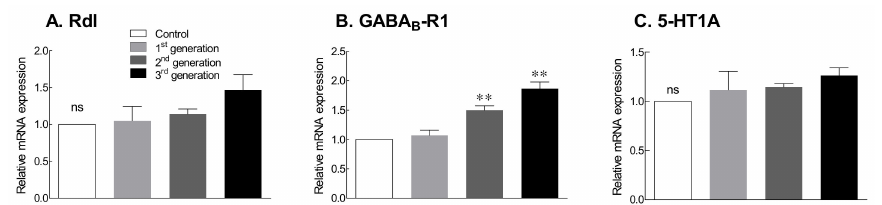
Figure 4. Effects of the GABA/5-HTP mixture (1.0% and 0.1%, respectively) on Rdl ( A ), GABA B -R1 ( B ), and 5-HT1A ( C ) mRNA expression in Drosophila flies by generation. Data are presented as means ± standard error of the mean for each group. Mean values with different letters over the bars indicate significant difference (** p < 0.01) according to Student’s t -test. ns, not